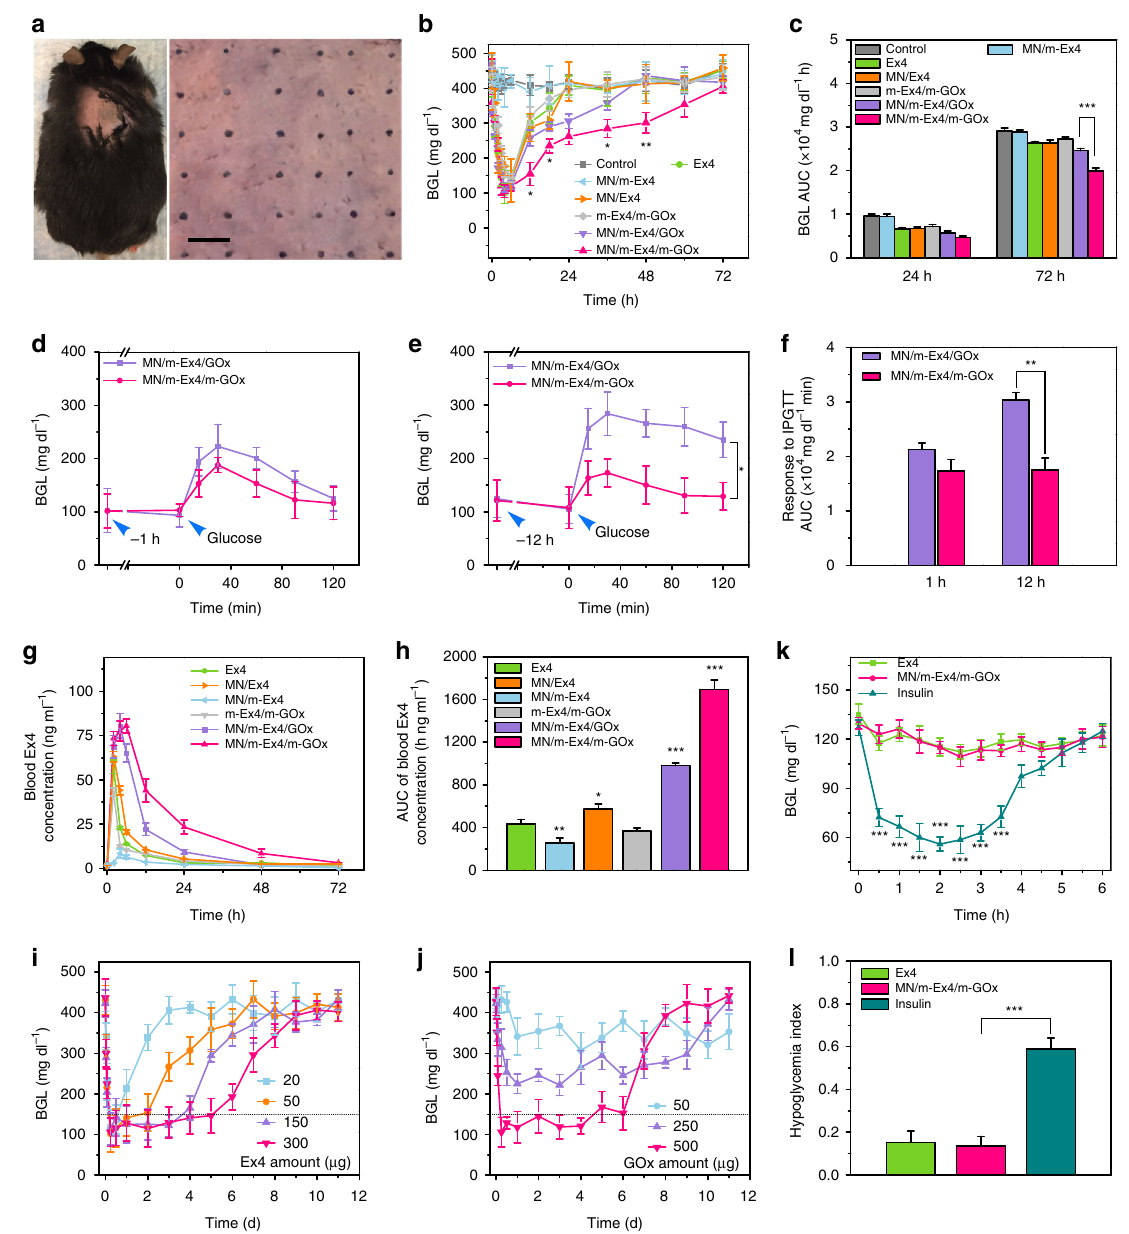
Fig. 6 In vivo studies of the MN-array patches for T2D therapy. a Photograph of the mouse treated by an MN patch at the dorsum; trypan blue staining showing microchannels after MN patch treatment. Scale bar, 500 µ m. b Long-term BGL monitoring in C57BL/6 db/db mice under different treatments. Mean ± S.D. ( n = 3). *P < 0.05, **P < 0.01 for MN/m-Ex4/m-GOx treated group compared with MN/m-Ex4/GOx treated group (two-tailed Student ’ s t - test). c The area under the curve (AUC) of BGL integrated up to 24 and 72 h. Mean ± S.D. ( n = 3). ***P < 0.001 (two-tailed Student ’ s t -test). IPGTT of diabetic mice at 1 h d and 12 h e post-administration of MN/m-Ex4/GOx and MN/m-Ex4/m-GOx. Mean ± S.D. ( n = 3). *P < 0.05 (two-tailed Student ’ s t - test). f Responsiveness to IPGTT was calculated based on the AUC over 120 min. Mean ± S.D. ( n = 3) **P < 0.01, (two-tailed Student ’ s t -test). g Blood drug concentration vs. time curves of different treatments. Mean ± S.D. ( n = 3). h AUC of blood drug concentration up to 72 h. Mean ± S.D. ( n = 3) *P < 0.05, **P < 0.01, *** P < 0.001 for administration with different formulations compared with Ex4 (two-tailed Student ’ s t -test). i Long-term BGL monitoring in C57BL/6 db/db mice under MN/m-Ex4/m-GOx administration with different Ex4 amounts. Mean ± S.D. ( n = 3). j Long-term BGL monitoring in C57BL/6 db/db mice under MN/m-Ex4/m-GOx administrations with different GOx amounts. Mean ± S.D. ( n = 3). k Blood glucose changes of healthy mice administered with Ex4, MN/m-Ex4/m-GOx, and insulin. Mean ± S.D. ( n = 3). *** P < 0.001 for insulin treated group compared with MN/m-Ex4/m- GOx treated group (two-tailed Student ’ s t -test). l Quanti fi cation of the hypoglycemia index, which was calculated from the difference between the initial and nadir blood glucose readings divided by the time at which nadir was reached. Mean ± S.D. ( n = 3). *** P < 0.001 (two-tailed Student ’ s t